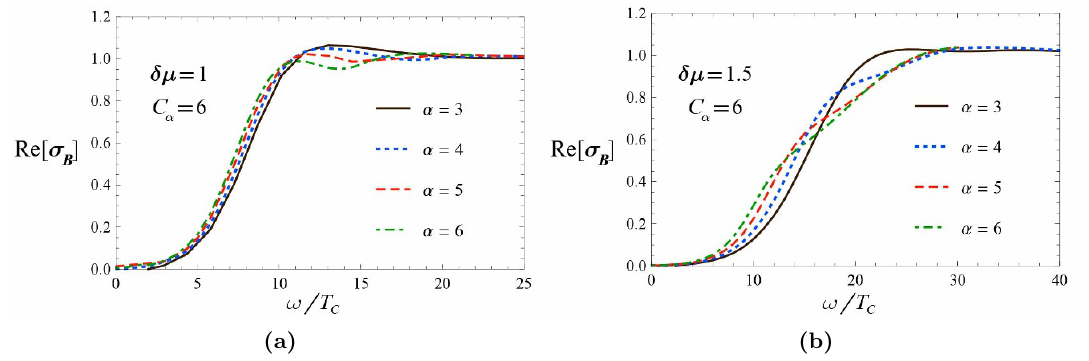
Figure 18. The optical spin conductivities in terms of !=T c for function F ( ) = 2 + C (cid:11) (cid:11) with (cid:11) = 3 ; 4 ; 5 ; 6 (solid curve, dotted curve, dashed curve, and dot-dashed curve) and (cid:12)xed C (cid:11) = 6. The left and right (cid:12)gures belong to systems with (cid:14)(cid:22) = 1 and 1 : 5.